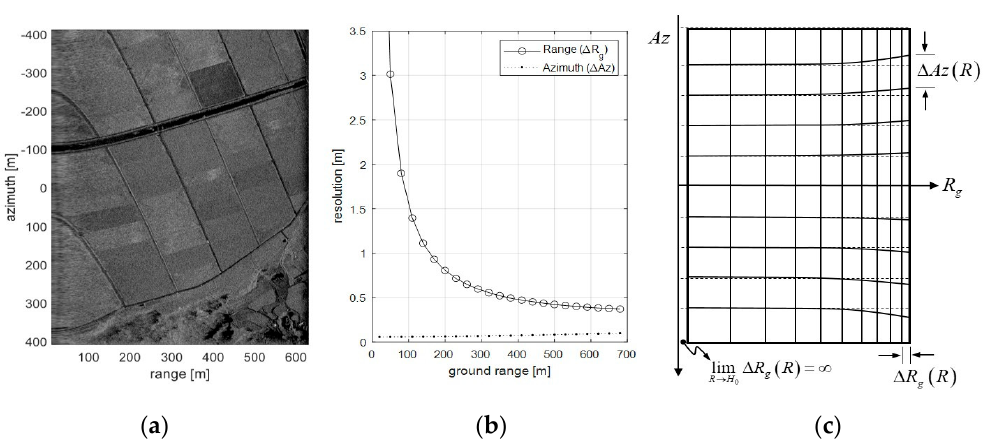
Figure 10. Resolution variation of the SAR image reconstructed with the raw data acquired within the range of low incident angle: ( a ) is an SAR image reconstructed by the range doppler algorithm; ( b ) is a calculated resolution; and ( c ) is a resolution grid depicted exaggeratedly for the near zone SAR image.